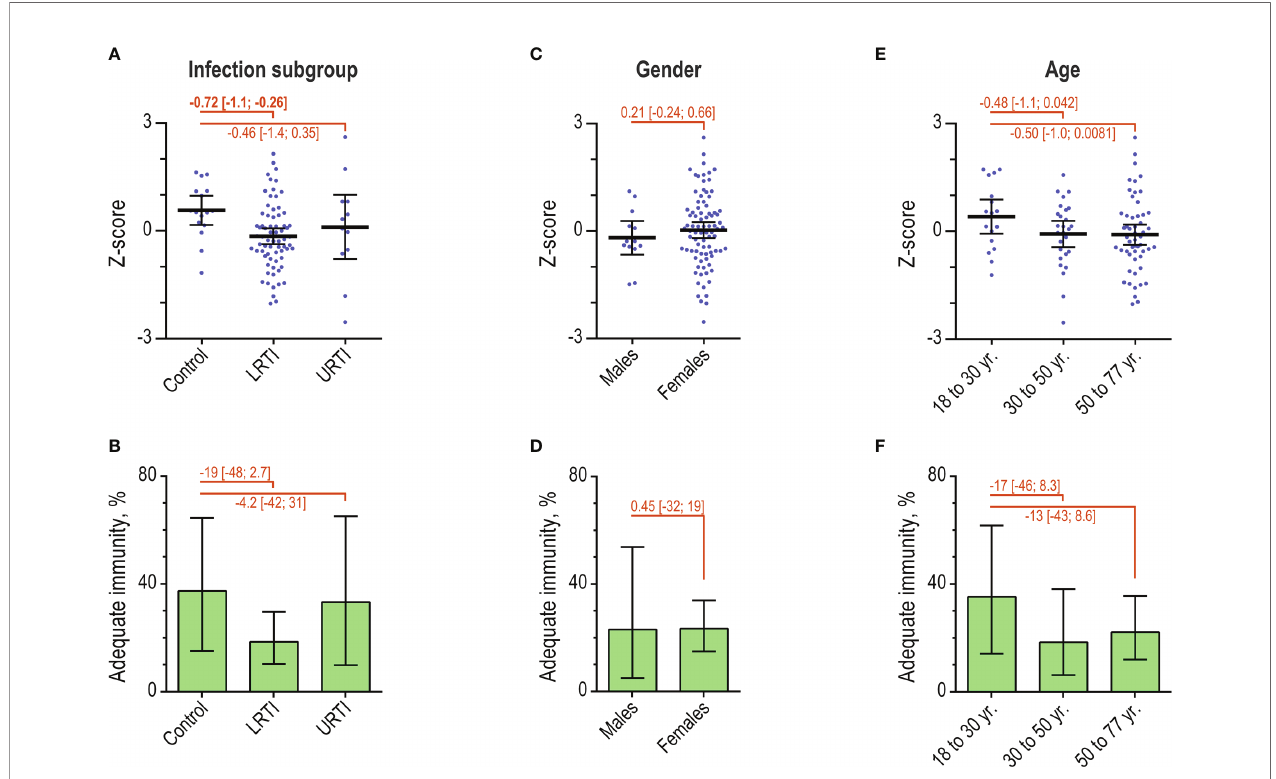
FIGURE 7 | Immunity after PPV in patient subgroups. (A) Individual Z-scores and mean with 95% con fi dence interval for patients ( n = 98) by infection pro fi les. Differences between groups were determined as indicated. (B) The percentage of patients with ‘ adequate ’ immunity according to the AAAAI guidelines, by infection pro fi les. Error bars are 95% con fi dence intervals. (C) As in A, but for patients by gender. (D) As in B, but for patients by gender. (E) Individual Z-scores for patients by age intervals. (F) As in B, but for patients by age